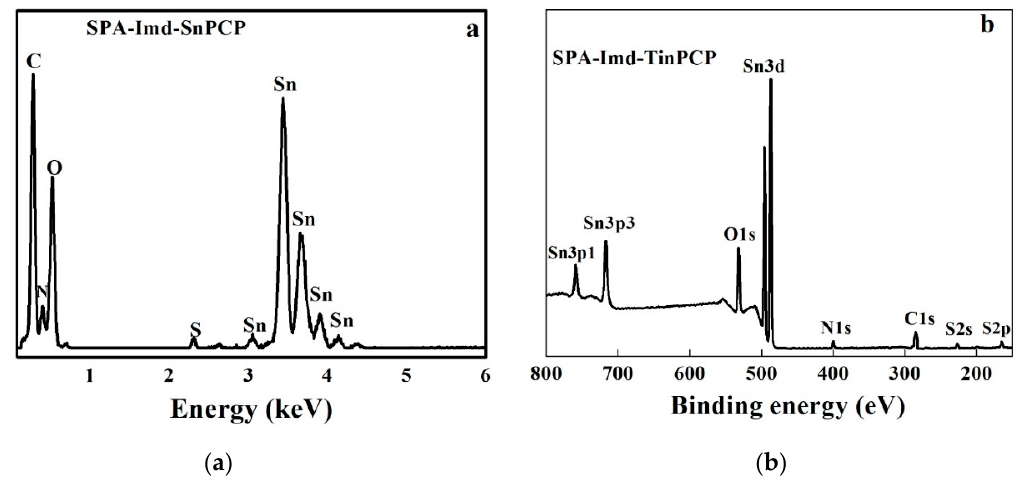
Figure 2. ( a ) EDS spectrum; ( b ) XPS spectrum of SPA-Imd-TinPCP.